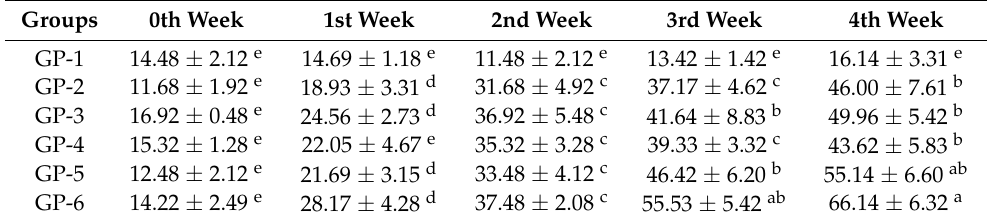
Table 3. Serum 25-hydroxyvitamin D levels (ng/mL) of all groups measured at weekly intervals. Groups